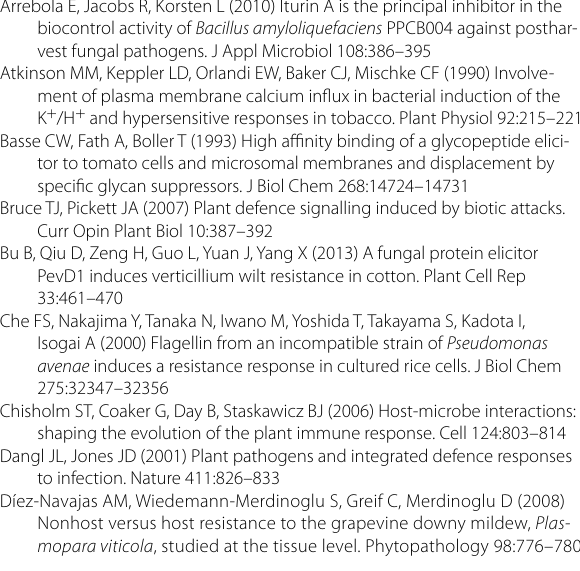
Additional file 1: Figure S1. The mass spectrometry of the target protein. Figure S2. Amino acid sequence information of AMEP412 (WP_017418614.1). Amino acid sequence of AMEP412 in the one letter code. A predicted secondary structure is given in the lower line. H, Alpha helix; C, random coiled. Bold and italic letters, the peptide fragments detected by MS sequencing. Underlined, the predicted transmembrane domain.